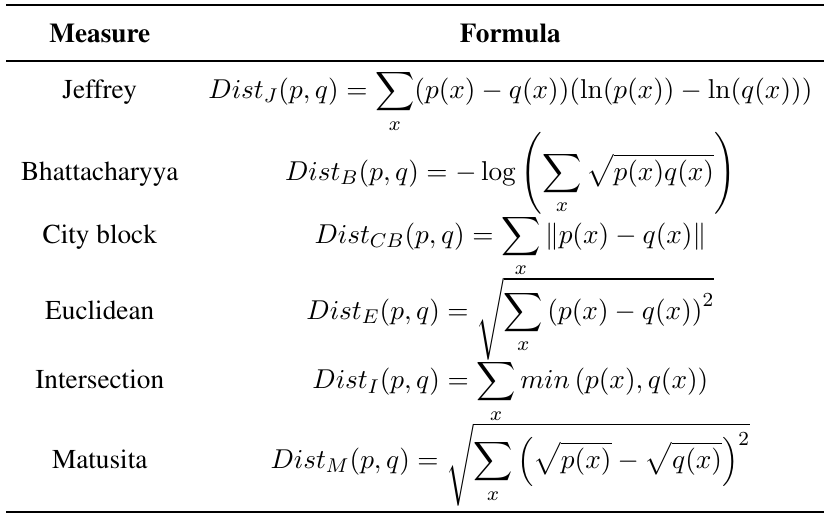
Table 1. List of histogram similarity